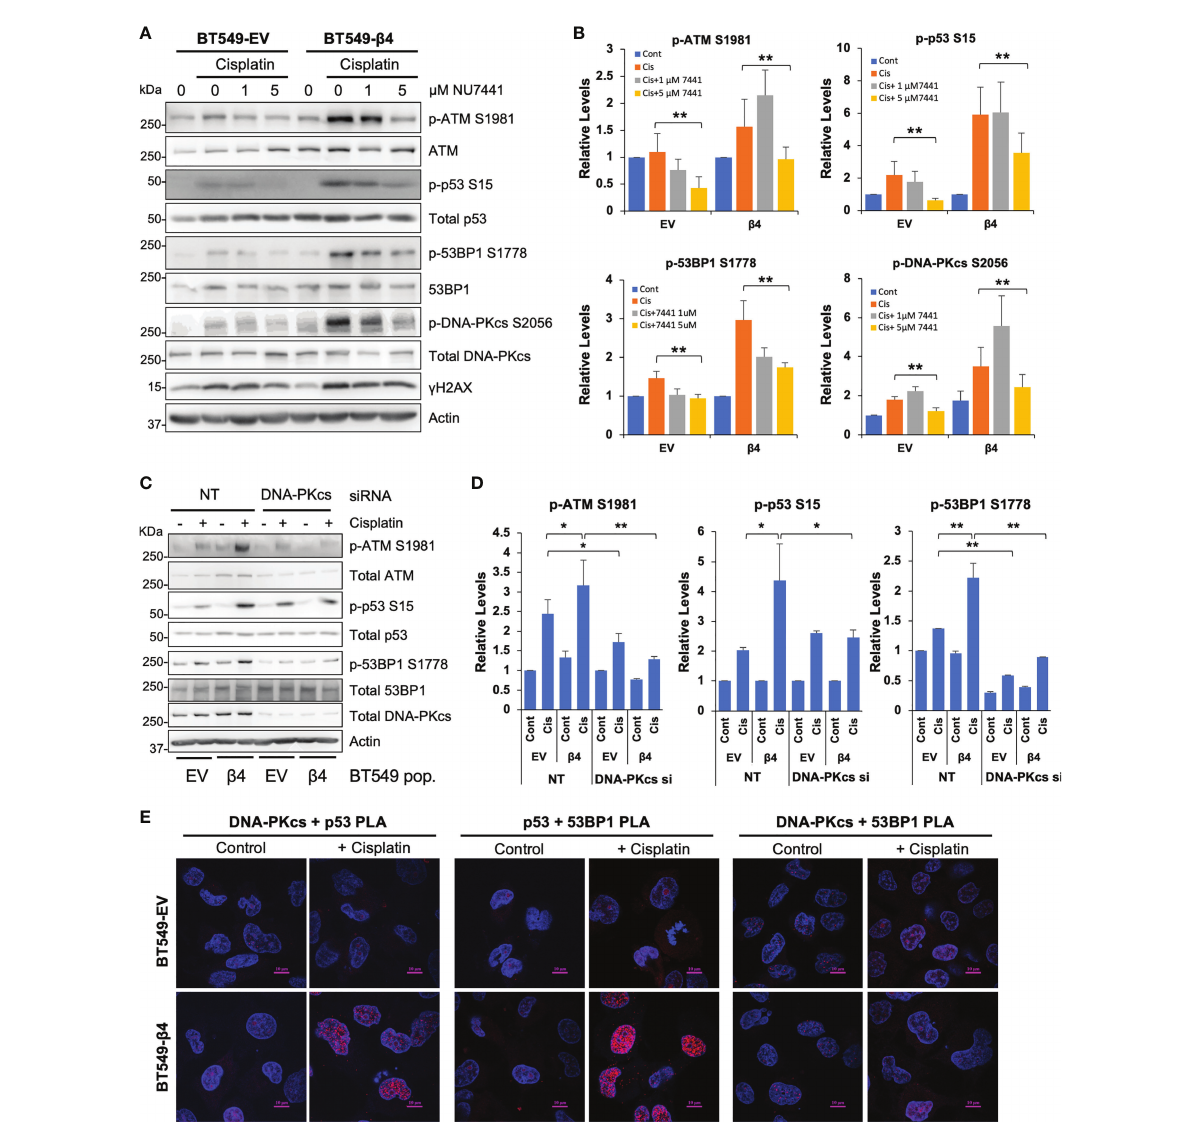
FIGURE 6 DNA-PK is activated and required for phosphorylation of ATM, 53BP1 and p53 downstream of integrin a 6 b 4. BT549 cells (EV and b 4) were plated on laminin-1-coated plates, pretreated with DNA-PK inhibitors NU7441 (A) at indicated concentrations for 1 hr, or electroporated with 200nM non-targeting siRNA or siRNA targeting DNA-PKcs for 72h (C) before treatment with 10µM cisplatin for 24h. Cell lysates were then immunoblotted for signaling proteins in DNA repair pathway as noted and quanti fi ed as fold change compared to total protein controls (B, D) . *p < 0.05, **p < 0.005. (E) BT549 cells (EV and b 4) plated on laminin-1-coated coverslips were treated with 10µM cisplatin for 24h and then the associations of DNA-PKcs, p53, and 53BP1 were assessed by PLA, as noted. Scale bars,